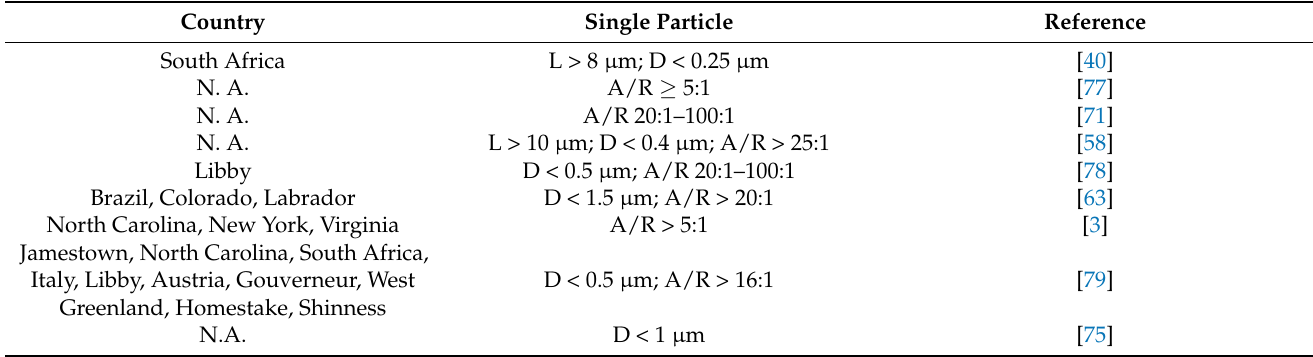
Table 2. Counting criteria adopted for asbestos identification procedures from different countries or institutions. L = length; D = diameter; A/R = aspect ratio [Modified from 6]. Country Single Particle Reference South Africa